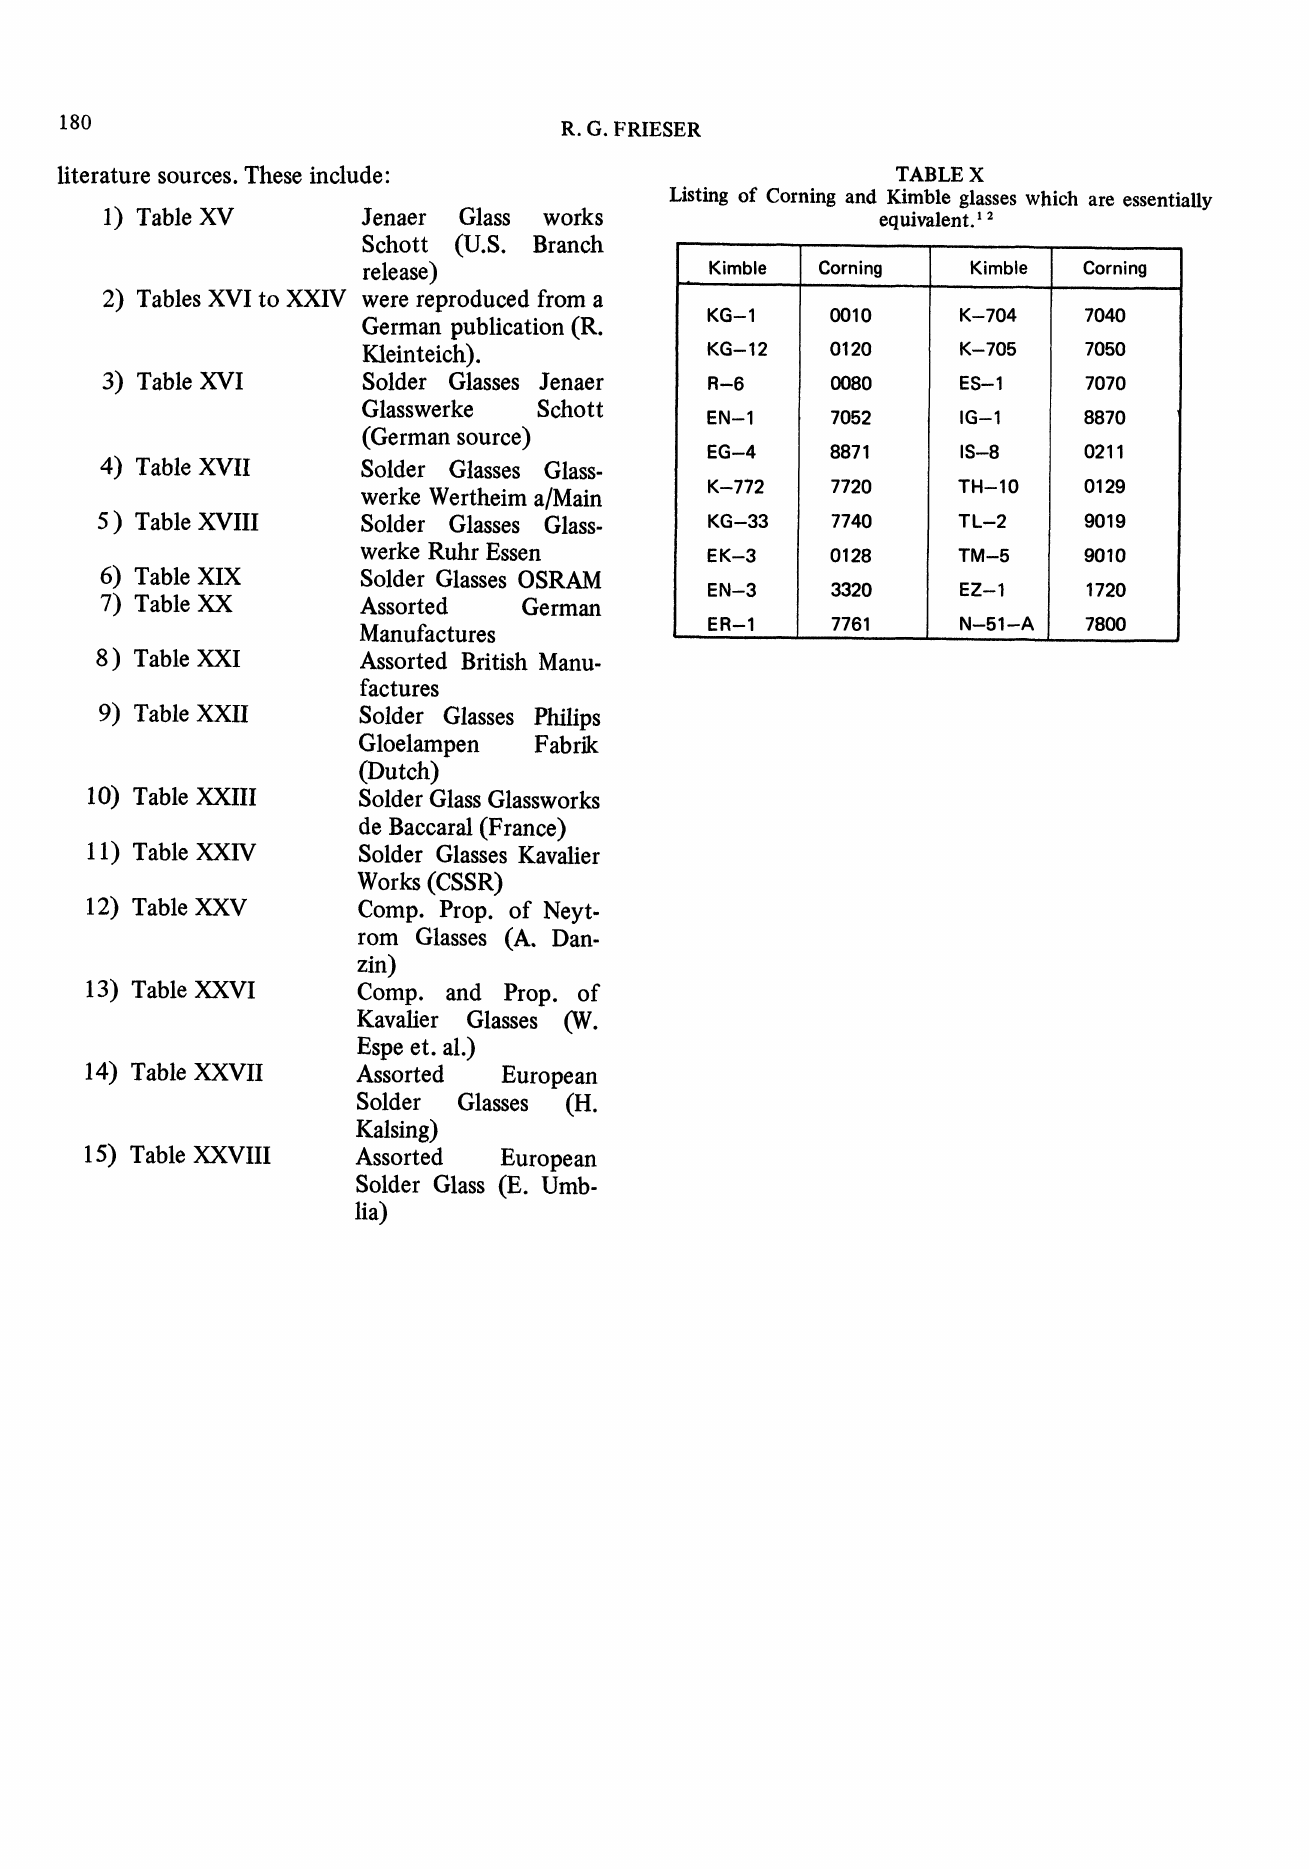
TABLE X Listing of Coming and Kimble glasses which are